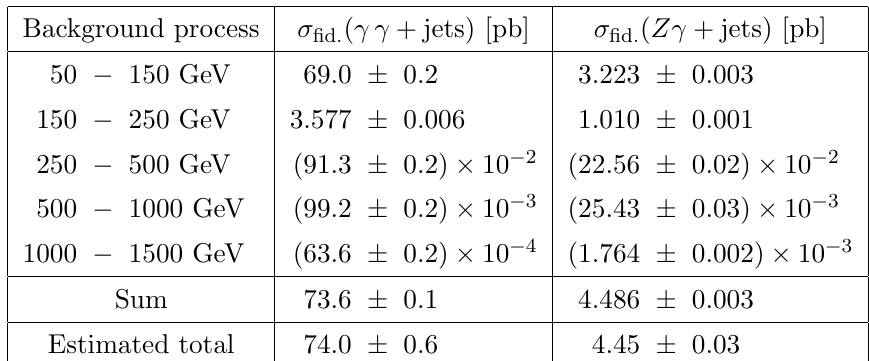
Table 1 . Fiducial cross section for each mass slice of the two major background processes. For the (cid:13) (cid:13) + jets background the slices refer to M bkg while for the Z (cid:13) + jets background the slices refer to (cid:13)(cid:13) M bkg at the generator level. The sums of the (cid:12)ducial cross sections over all slices for each process Z(cid:13) are also listed together with their estimated value.